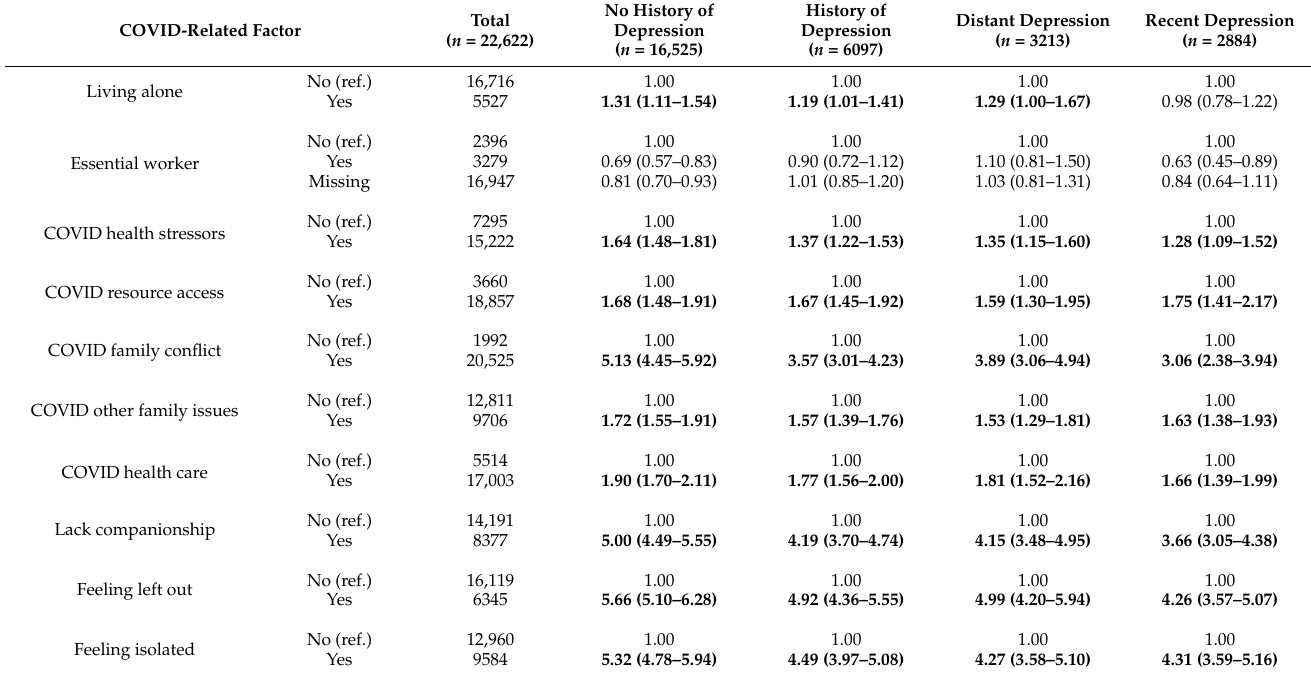
Table 4. Adjusted odds a (95% confidence interval) of depression during Autumn 2020 among those with no history of depression, any history of depression, recent depression (during follow-up 1 wave), and distant depression (prior to follow-up 1